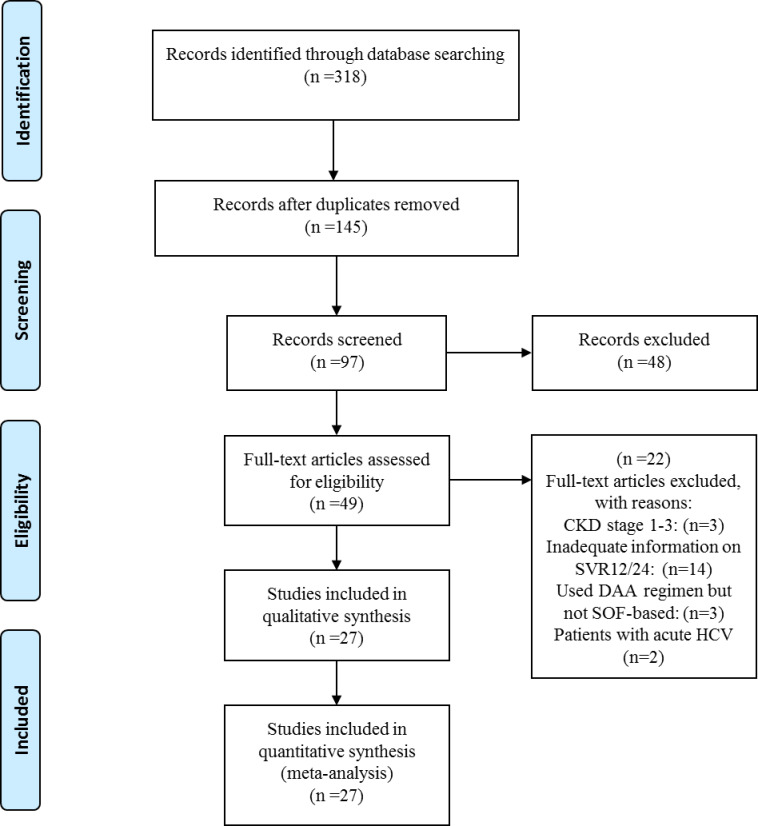
PRISMA flowchart showing different phases of selecting relevant publications.